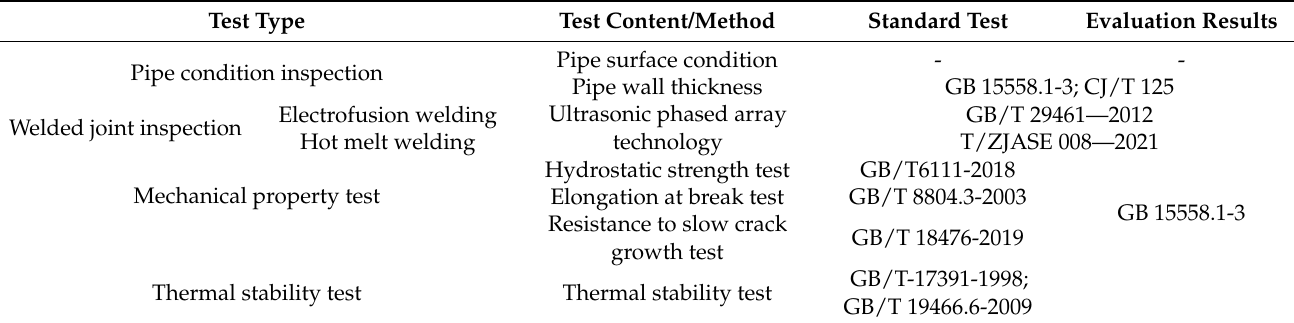
Table 2. Direct evaluation method of PE pipelines.